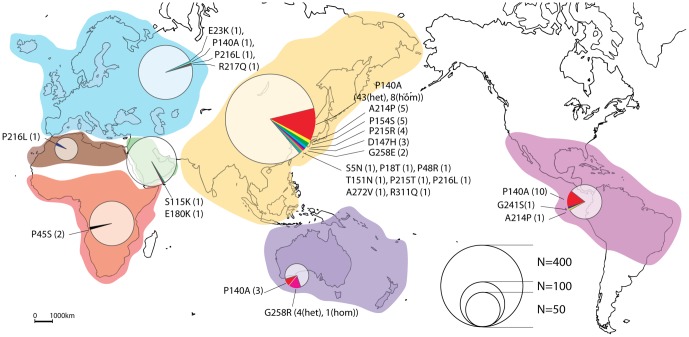

PRRT2 variants identified in individuals from worldwide populations.A total of 961 individuals from the human genome diversity panel (HGDP) were sequenced for all PRRT2 exons. The diameter of each circle is proportional to the number of individuals who were sequenced for PRRT2.